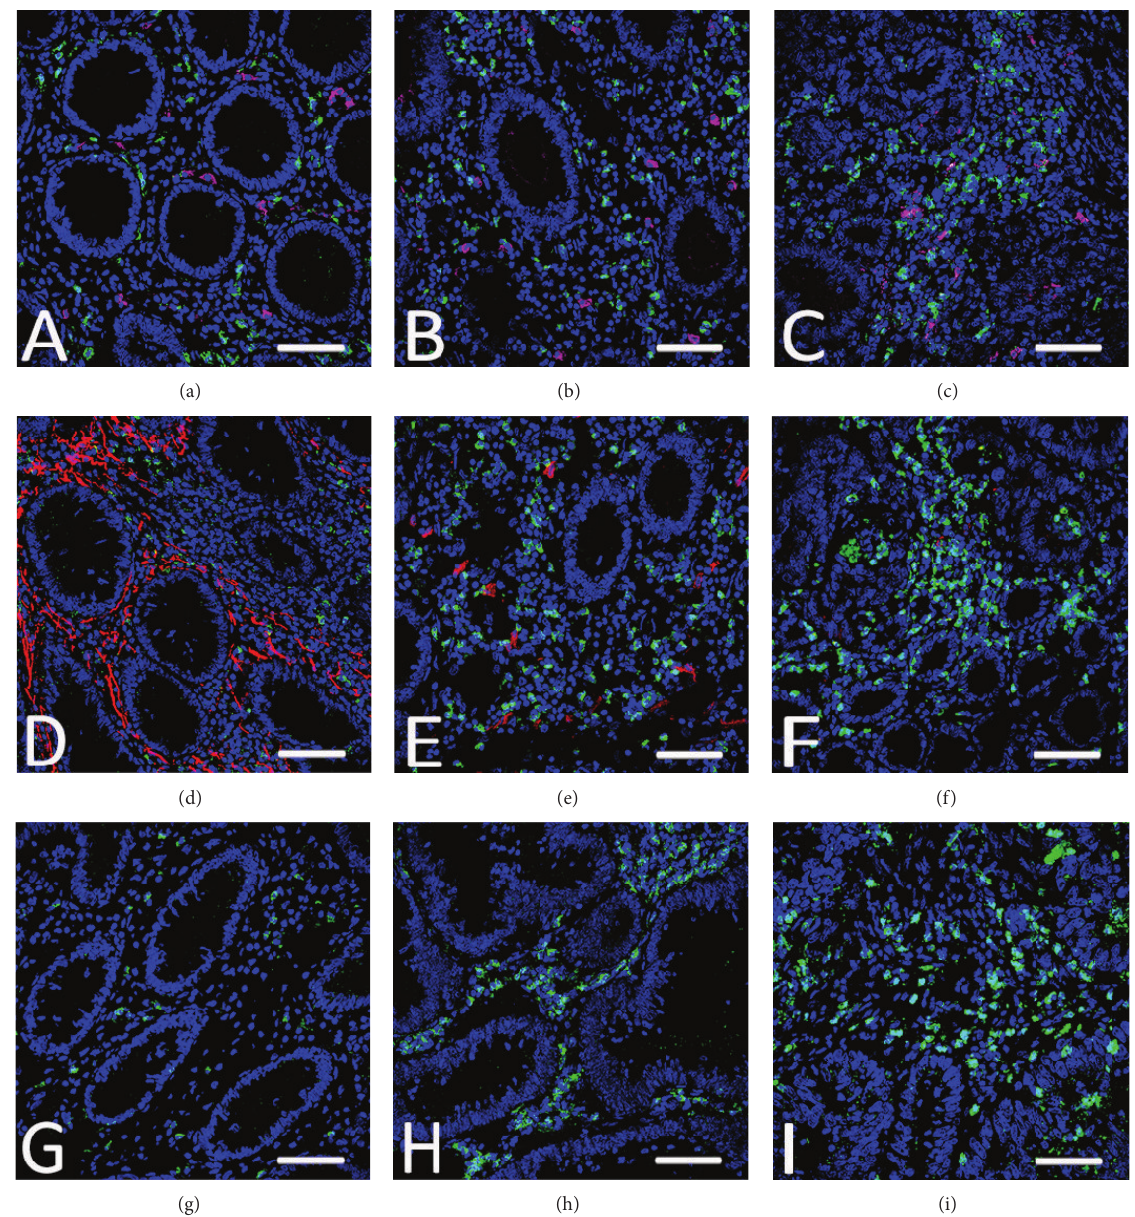
Figure 2: Confocal immunofluorescence staining of colorectal carcinogenesis. Examples of confocal analysis of cryosections of normal colorectal mucosa (NM), aberrant crypt foci (ACF), and colorectal carcinoma (CRC), labelled by DAPI (blue), PLZF (green), CD2 (magenta), and CD56 (red). (a)–(c): PLZF with CD2 in NM (a), ACF (b), and CRC (c). (d)–(f): PLZF and CD56 in NM (d), ACF (e), and CRC (f).